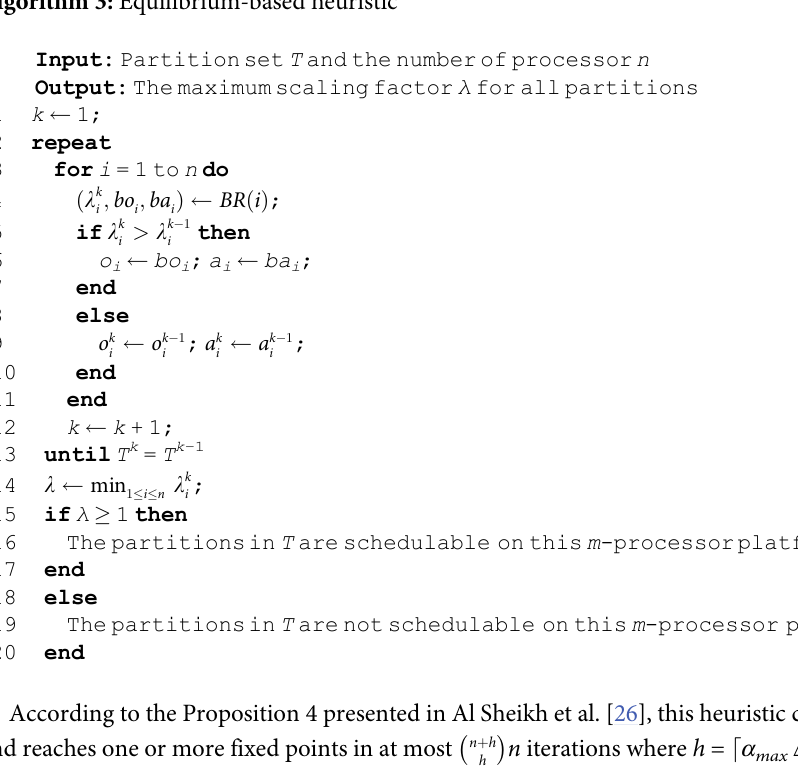
Algorithm 3: Equilibrium-based